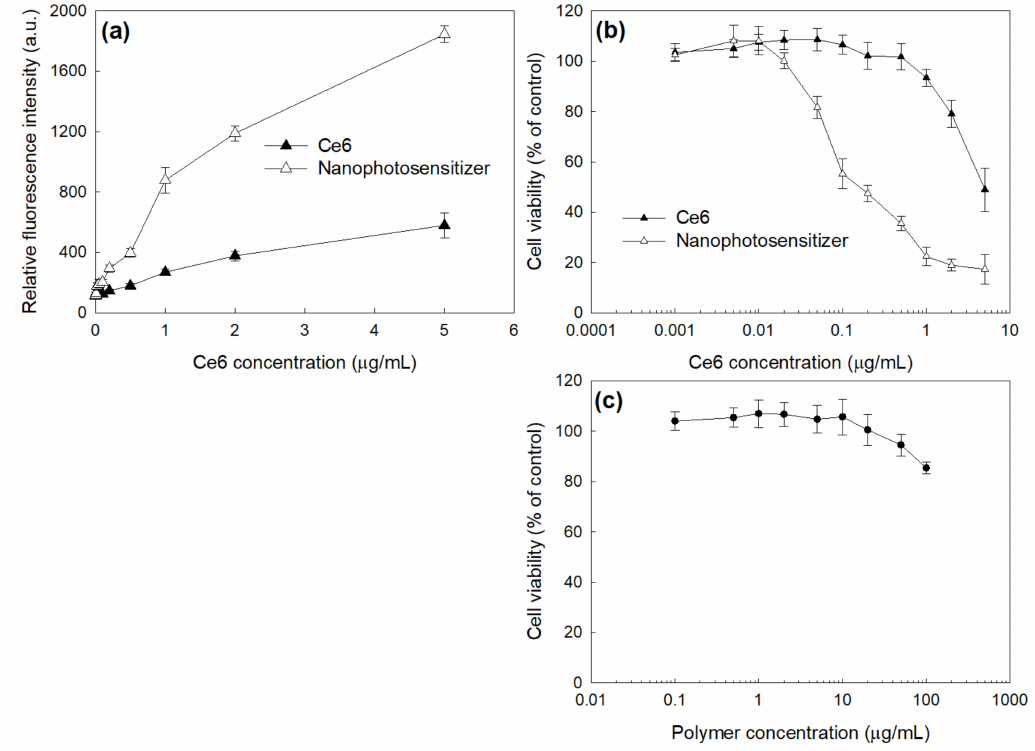
Figure 8. The effect of the Ce6 alone or nanophotosensitizers on the ROS generation ( a ) and phototoxicity ( b ) against HeLa cells. ( c ) The phototoxicity of empty nanophotosensitizers. The ROS generation was measured with a DCFH-DA assay. Cells (2 × 10 4 cells/well in 96 wells) were irradiated at 664 nm (2 J/cm 2 ). All values are average ± S.D. from results of a single independent experiment with eight